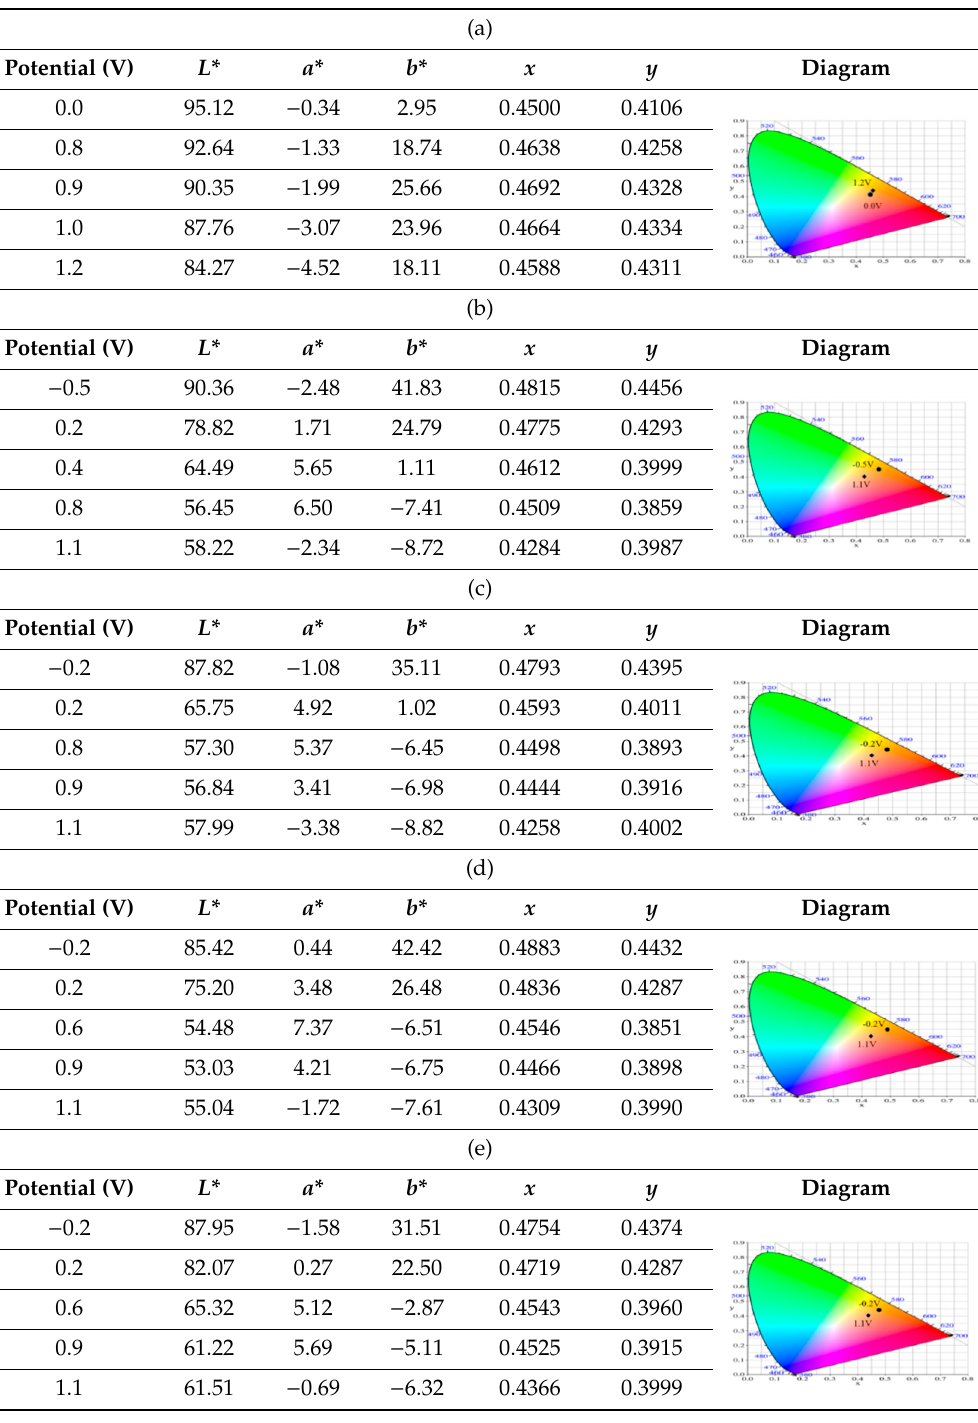
Table 2. Colorimetric values ( L *, a *, and b *), CIE chromaticity values ( x , y ) and diagrams of the ( a ) applied potentials.